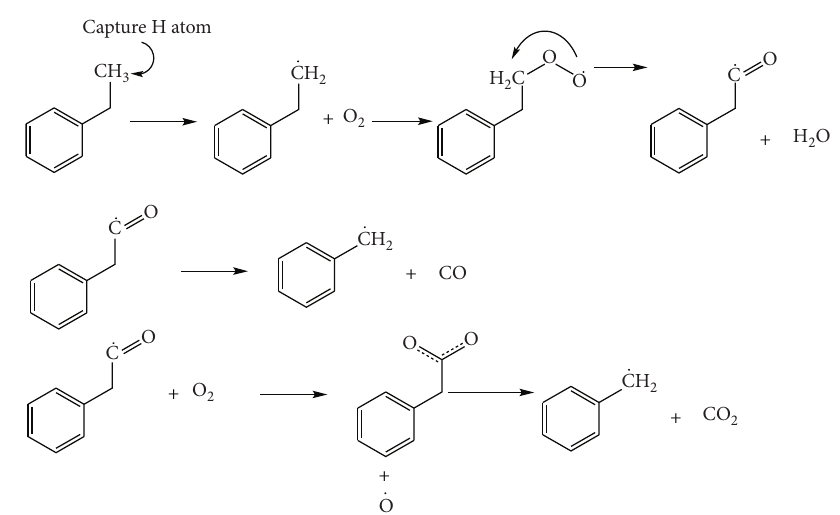
Figure 7: Chemical reactions of generating CO and CO